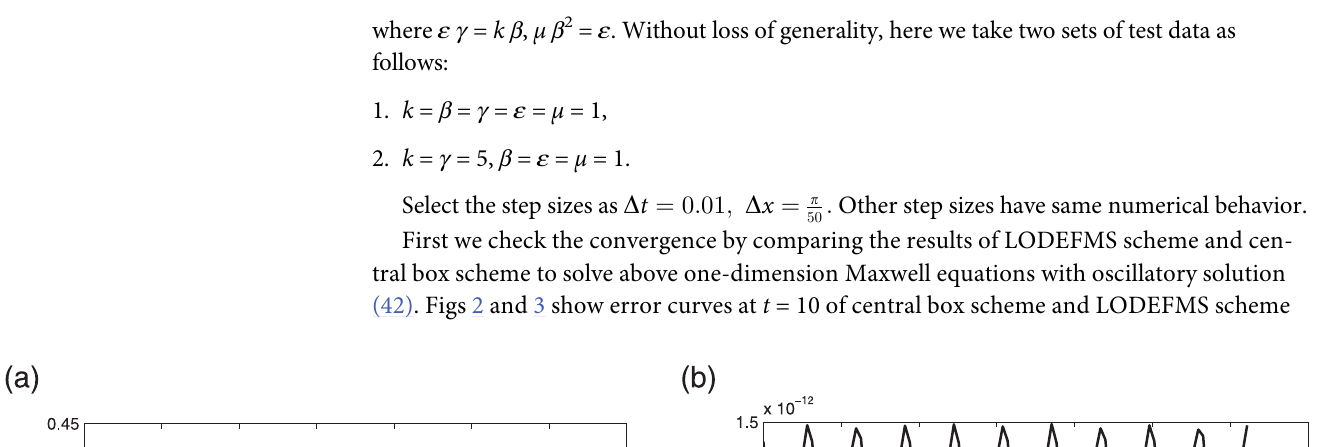
Fig 2. Numerical errors of central box scheme (left) and LODEFMS scheme (right) under first set of test data.